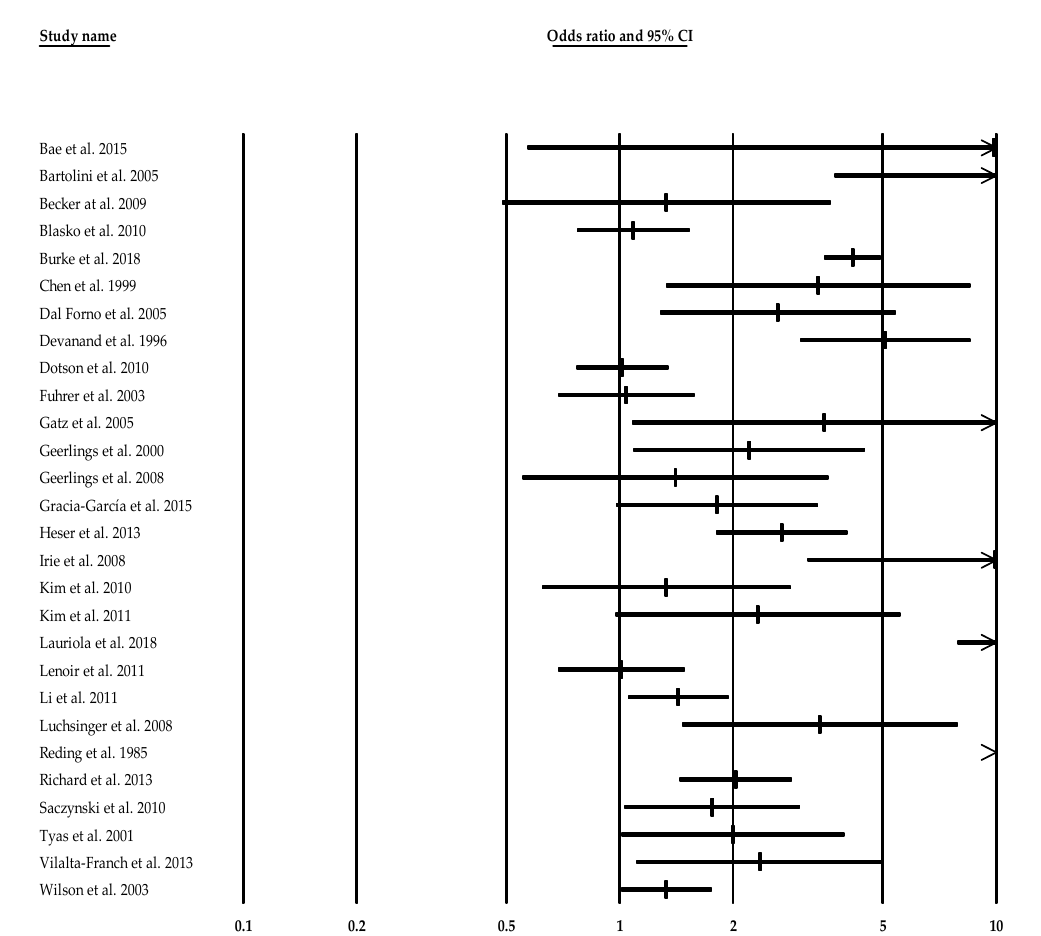
Figure 2. Forest plot of studies investigating the risk of Alzheimer’s disease (Time2) associated with depression (including all instruments).